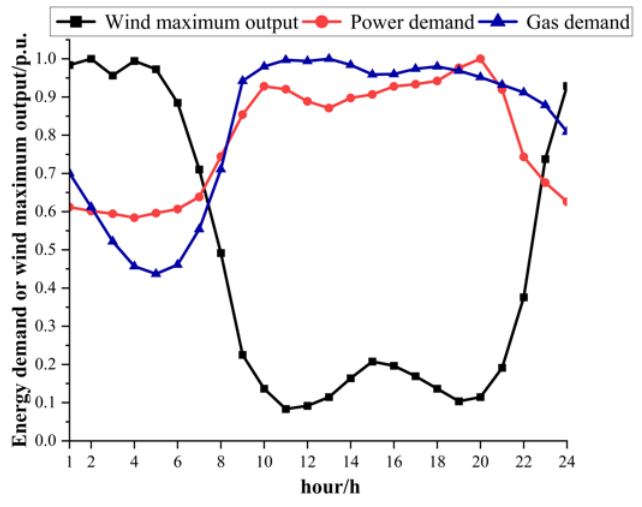
Figure 4. The modified IEEE 39-bus power system and the Belgian 20-node gas system.